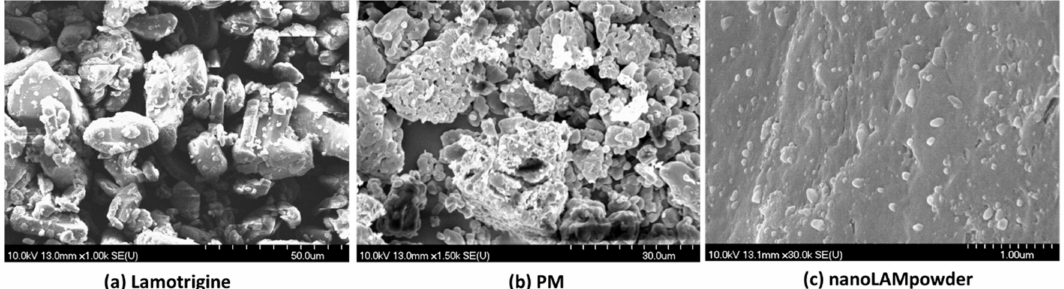
Figure 1. SEM pictures of the samples. In picture ( a ) raw LAM particles, in picture ( b ) the PM sample, and in picture ( c ) the nanoLAMpowder can be seen. Abbreviations: physical mixture (PM); nanonized lamotrigine containing nasal powder (nanoLAMpowder).